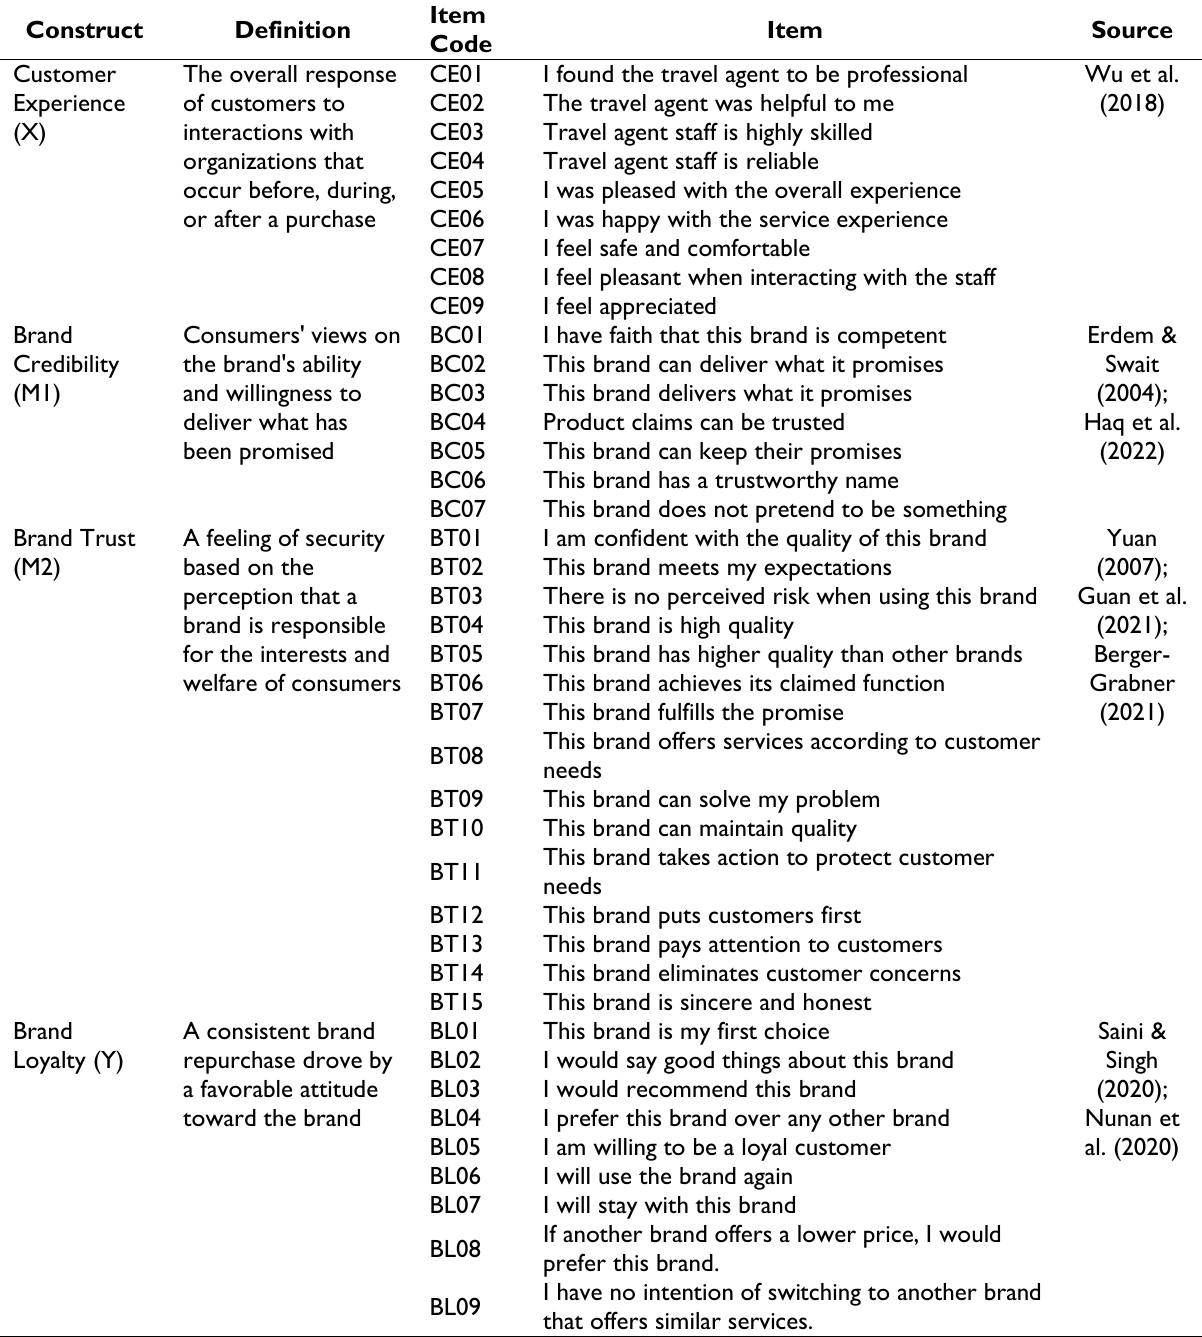
Table 1. Definition of Operational